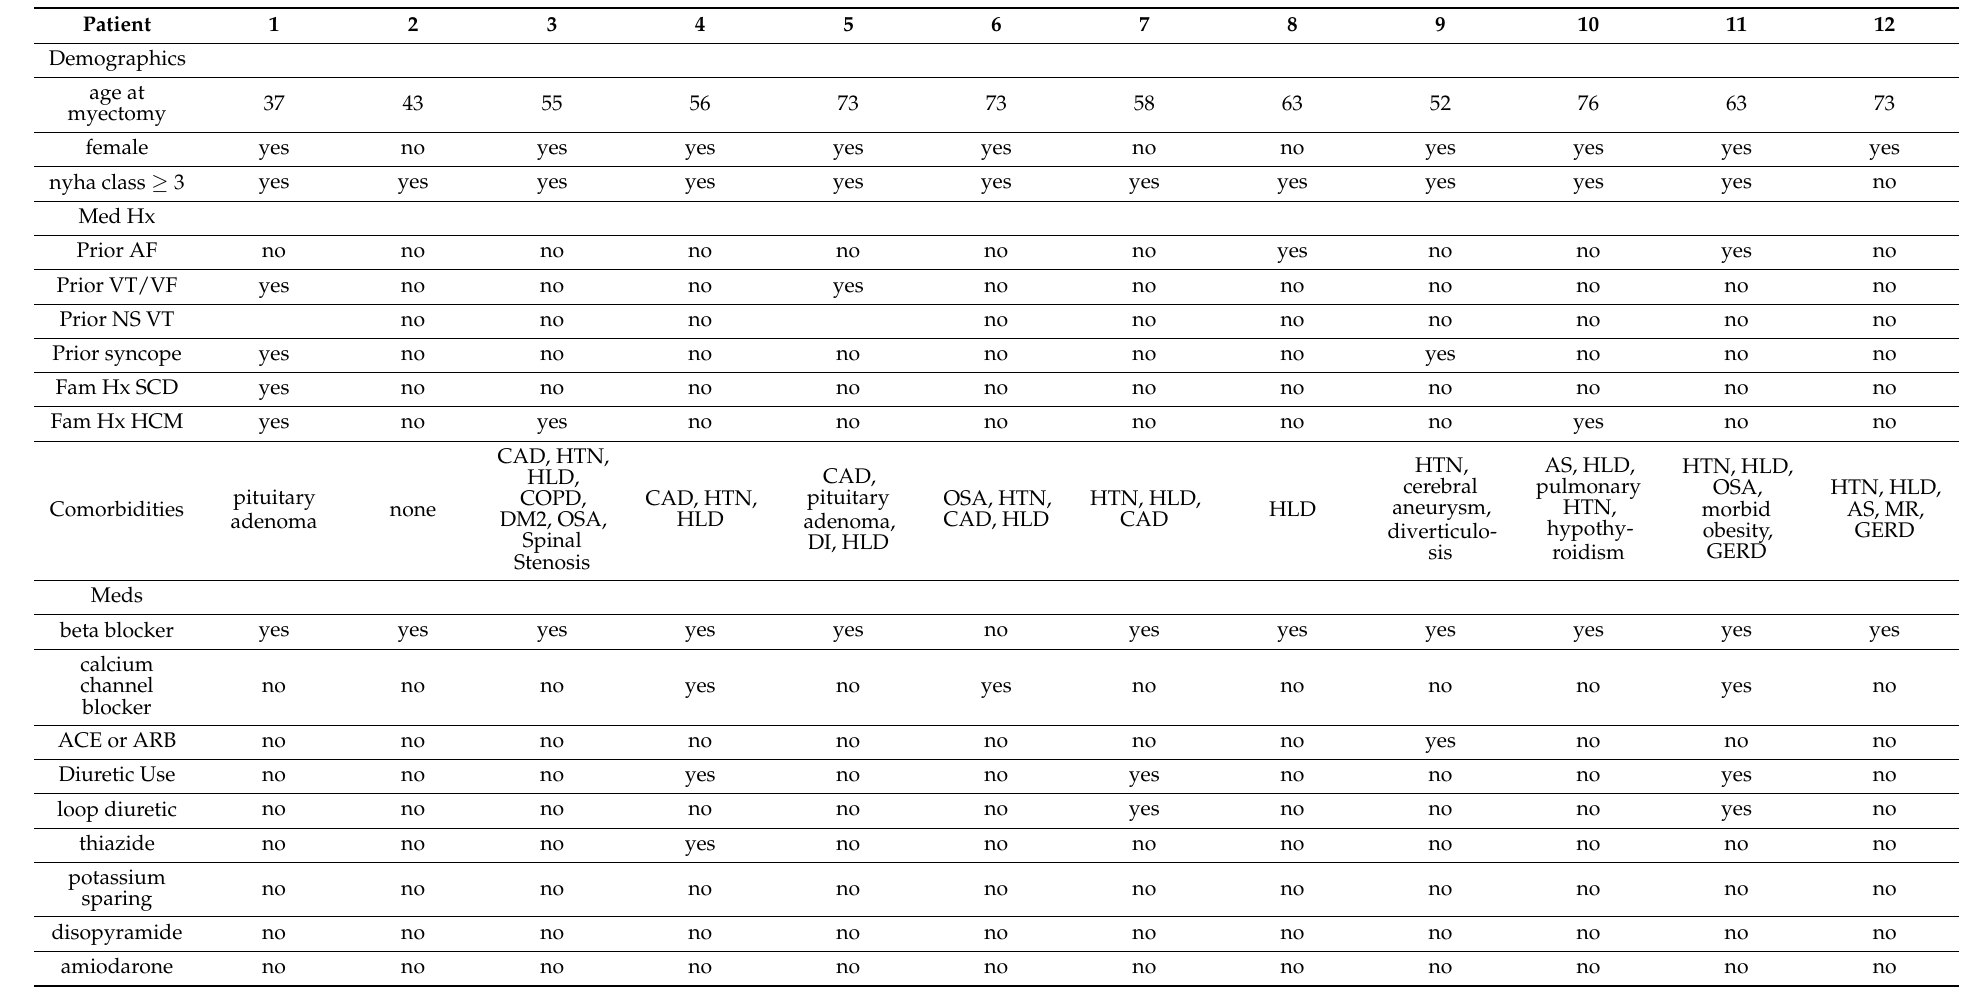
Table 1. Patient demographics and clinical characteristics for all